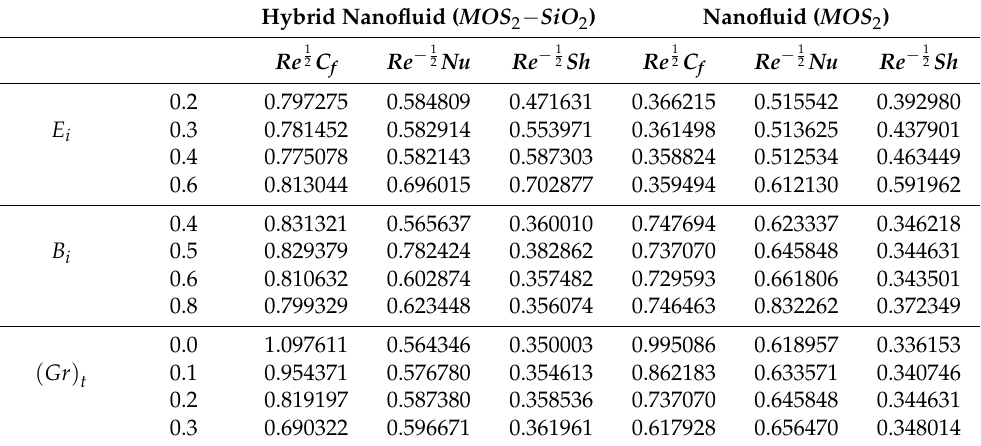
Table 5. Local skin friction coefficient, Nusselt number and Sherwood number for hybrid nanofluid ( MOS 2 − SiO 2 ) and nanofluid ( MOS 2 ) when M = 0.2, Pr = 2.36, Sr = 0.1, Sc = 0.8, ( Gr ) K = 0.1, and β ∗ =